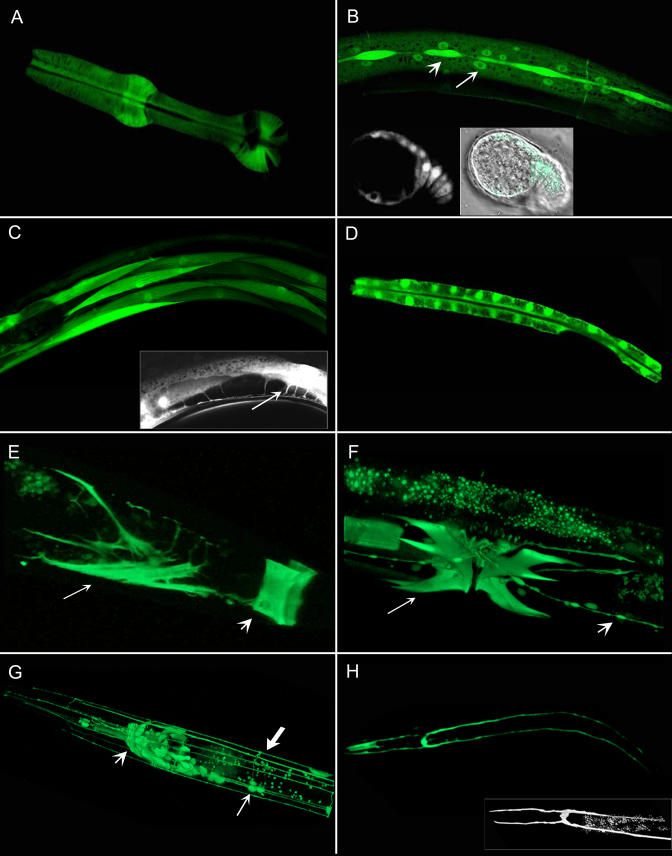
A Portrait of C. elegans General Tissue Expression Patterns, Driven by 5′ DNA::GFP Constructs(A) Pharynx—gene C32F10.8.(B) Hypodermis (long arrow) and seam cell (short arrow)—gene F25H2.1 (inset: C29E4.8—embryonic hypodermis).(C) Body wall muscle (arrow points to muscle arm)—gene F27D9.5 (inset: W01A11.1—muscle innervation).(D) Gut—gene Y102A11A.2.(E) Stomatointestinal muscle (long arrow) and anal depressor muscle (short arrow)—gene D1081.2.(F) Vulval muscle (long arrow) and ventral nerve cord (short arrow)—gene Y32H12A.5.(G) Neural (nerve ring: short arrow, ventral nerve cord: long thin arrow, and dorsal nerve cord: thick arrow)—gene C13F10.4.(H) Excretory cell—gene F32F2.1 (inset: F48E8.3) (intersects with WormBase annotation).